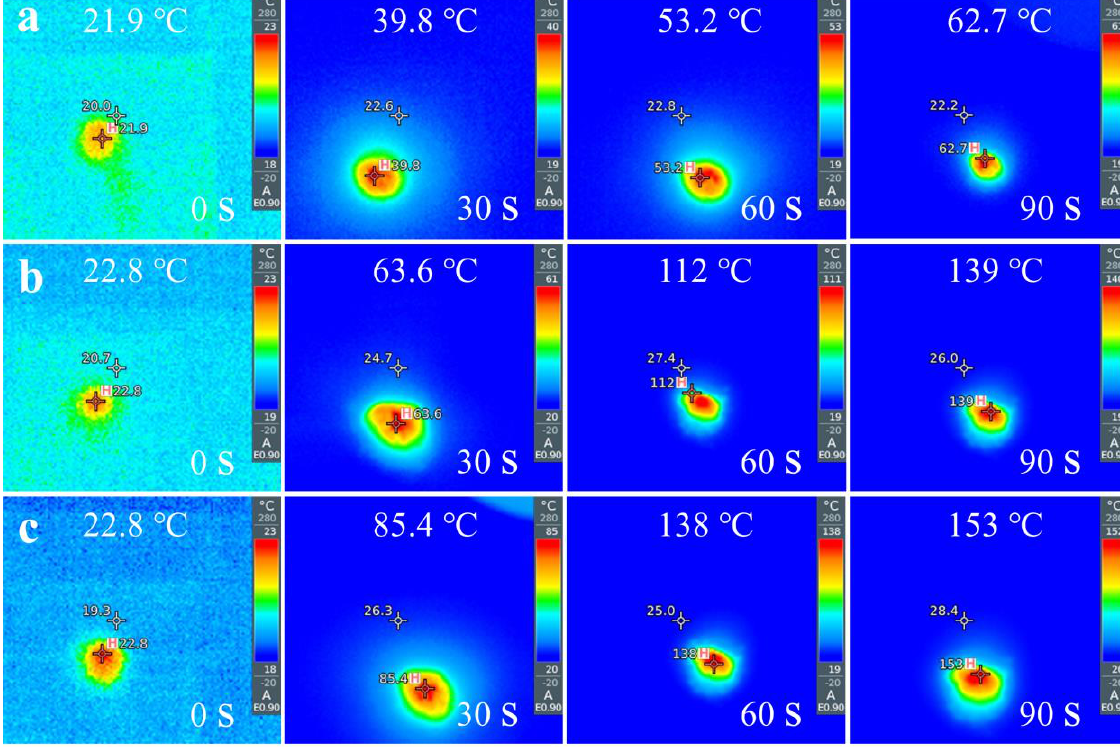
Figure 4. The IR images of temperature variation with light time for HCN ( a ), CIS ( b ), and HCN@CIS ( c ) ( The light source is a 300 W Xe lamp with a 420 nm filter).